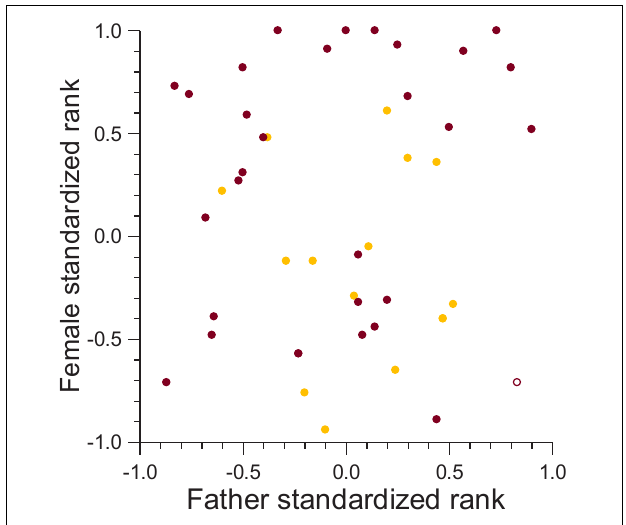
FIGURE 5 | The tenure of fathers in relation to the age of mothers on the date they conceived an offspring that was later a victim of either infanticide by violent attack (burgundy) or maternal neglect (amber). Filled symbol: immigrant males, open symbol: natal male. Points to the right of the broken line represent males which immigrated into the clan after the female was born, those to the left of the broken line immigrated before the female was born.